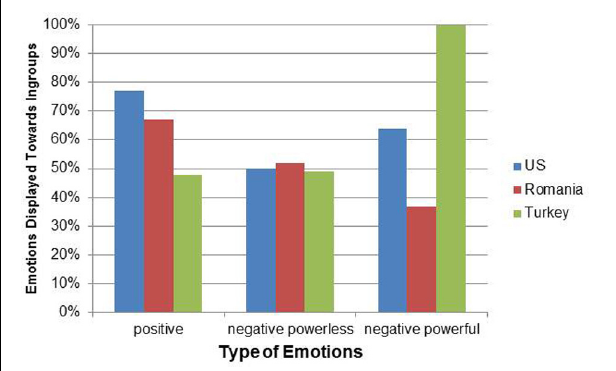
FIGURE 3 | Emotion displays toward ingroup members compared to outgroup members in relation to cultural groups and type of